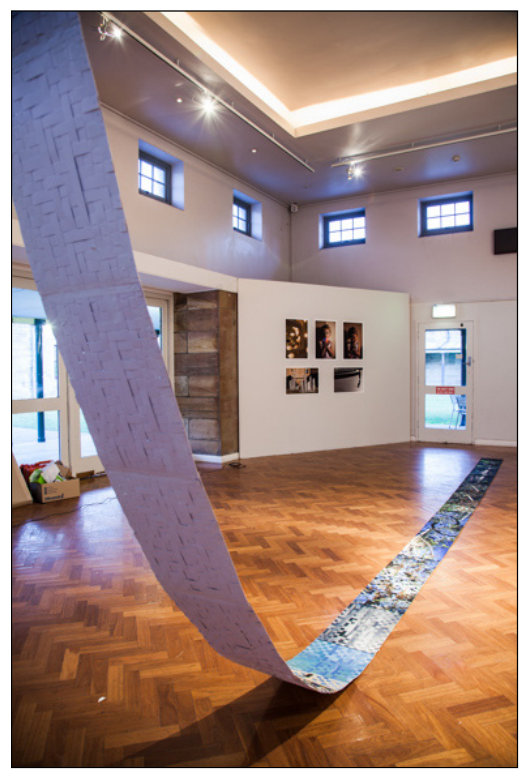
Figure 7. The Keeling (Over) Curve (years dot ‐ thru ‐ dash) in Facing Futures Free From Fear (2013).